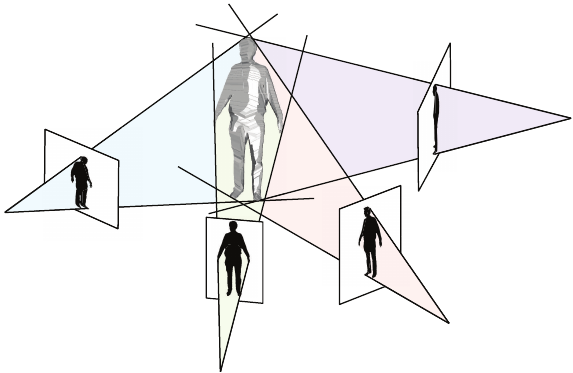
Figure 3: Visual hull of a person with 4